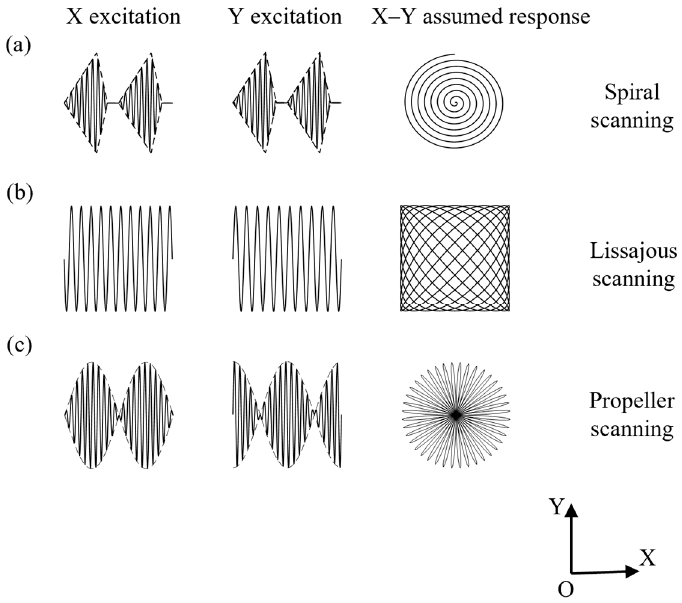
Figure 2. Different scanning patterns of resonant scanners: ( a ) spiral scanning; ( b ) Lissajous scanning; ( c ) propeller scanning.